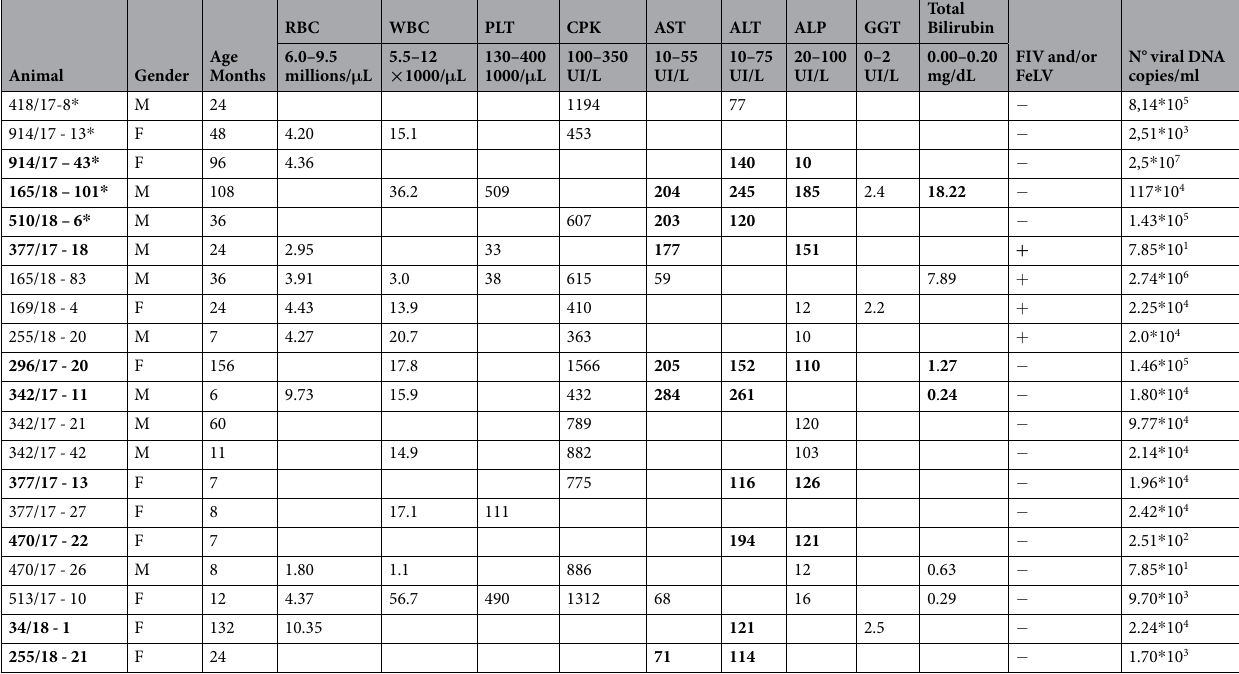
Table 1. List of DCH-positive animals with the corresponding hemato-chemicals parameters. Asterisks indicate group B animals. Animals with parameters indicative of functional and/or structural hepatic impairment are indicated in bold. Only parameters exceeding the normal ranges were reported in the